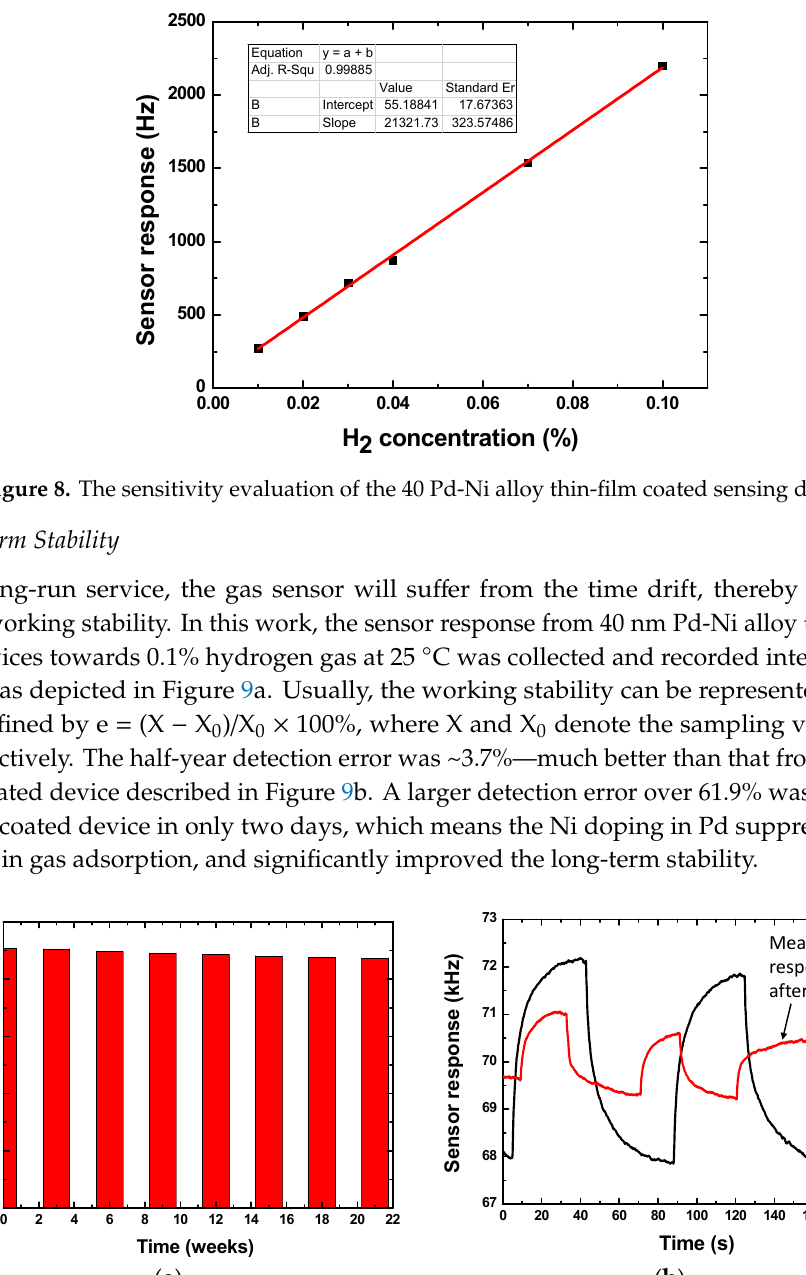
Figure 7. The measured sensor response relating to various hydrogen gas concentrations from the 40 nm Pd-Ni alloy thin-film coated sensing device.